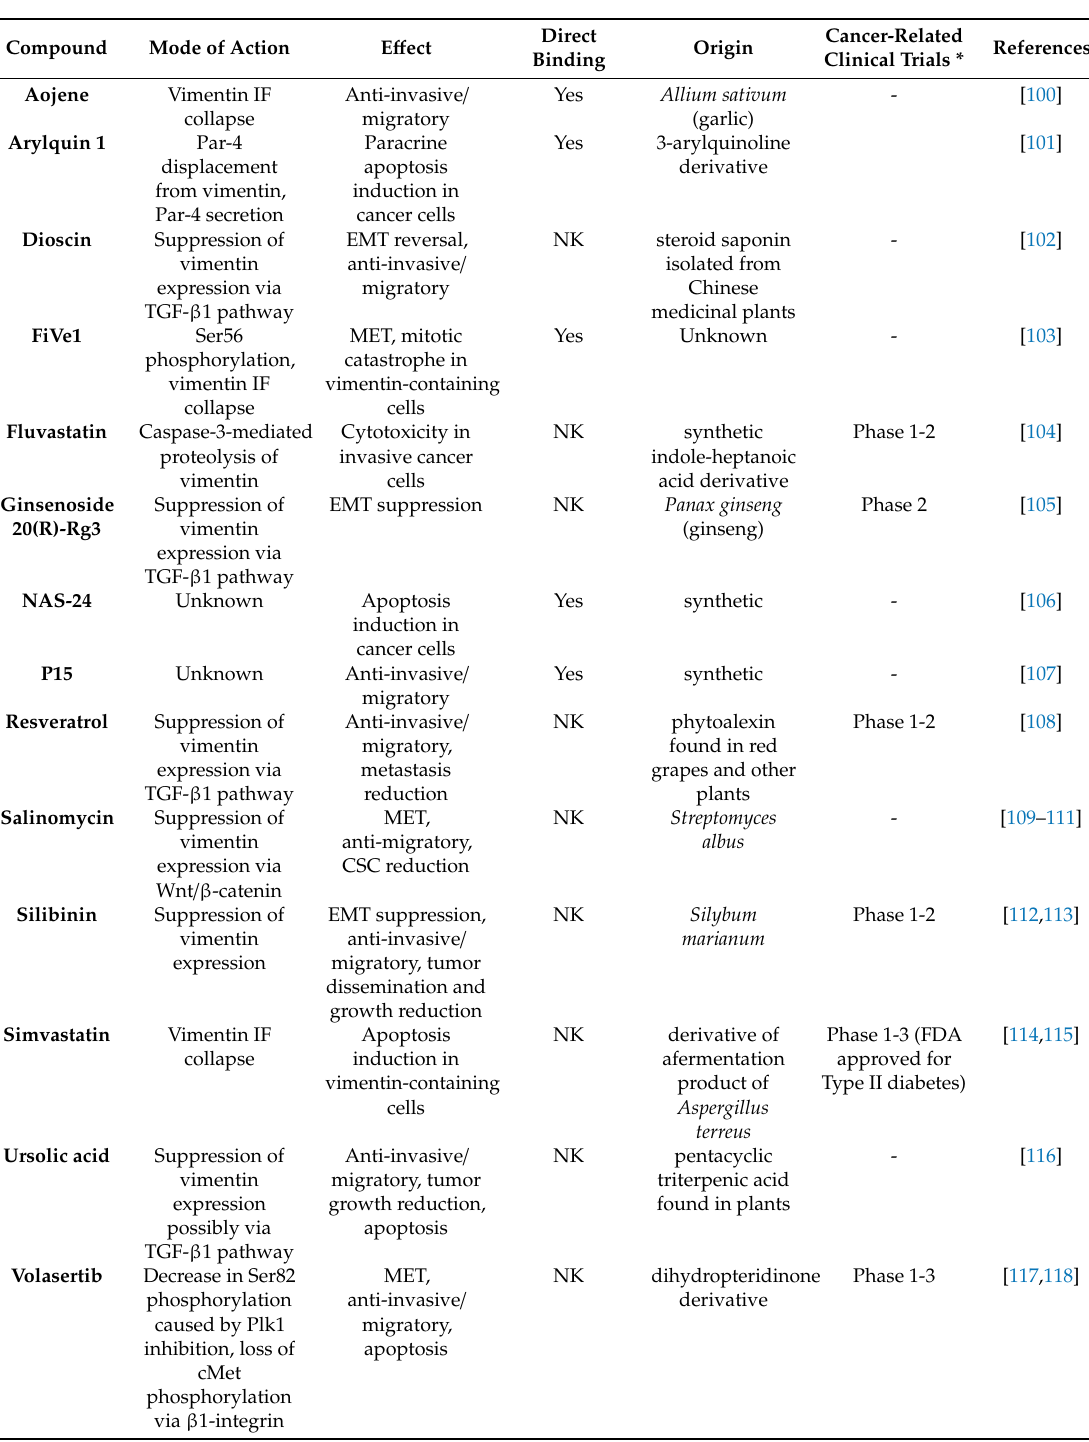
Table 1. Vimentin targeting